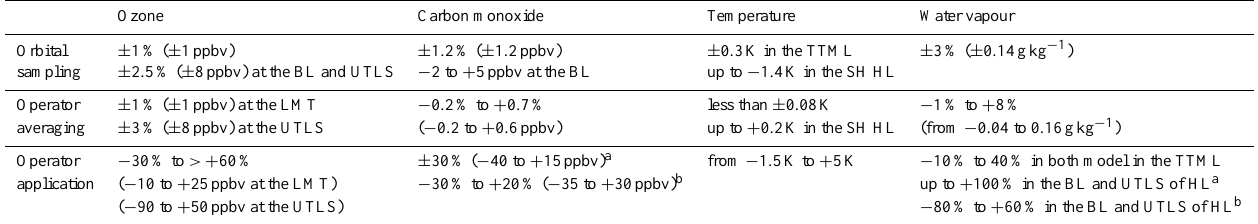
Table 2. The 2005–2008 zonal-mean percentage and absolute errors due to technical steps required to use sun-synchronous satellite in model evaluation. We show the biases due to (1) sampling the model along TES spatio-temporal resolution, (2) using monthly average of the satellite operators and (3) neglecting the application of satellite operators. The list of acronyms used in the Table is as given below. Ozone Carbon monoxide Temperature Water vapour